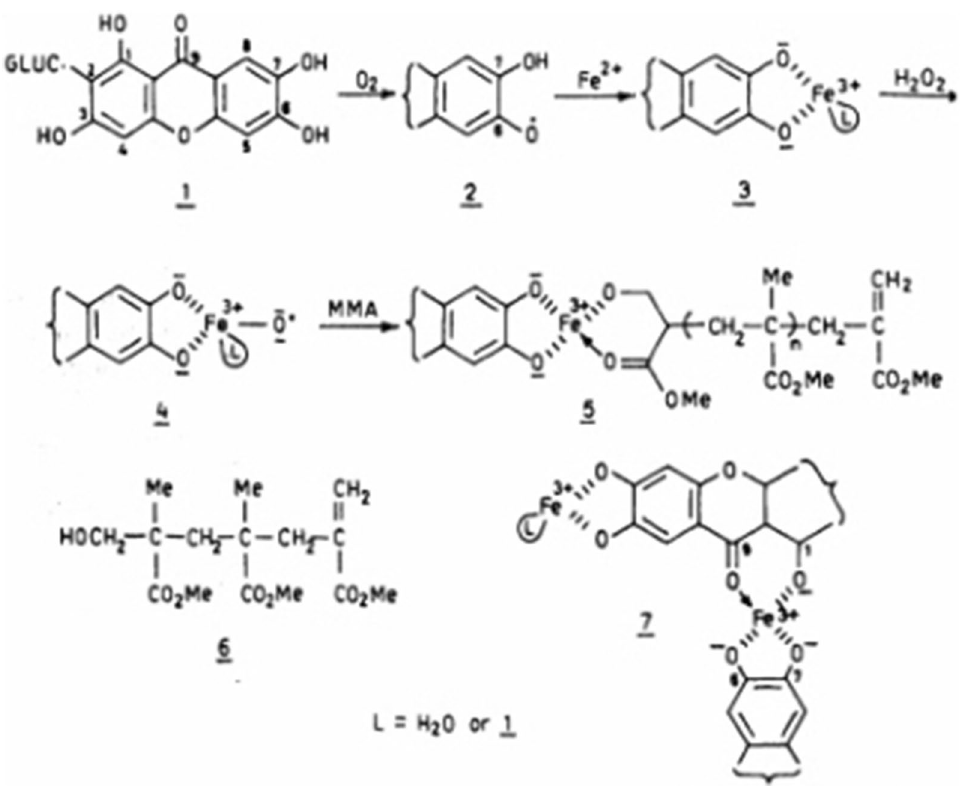
Fig. 3 Chemical representation of possible mechanism of action of mangiferin. Source: [36]